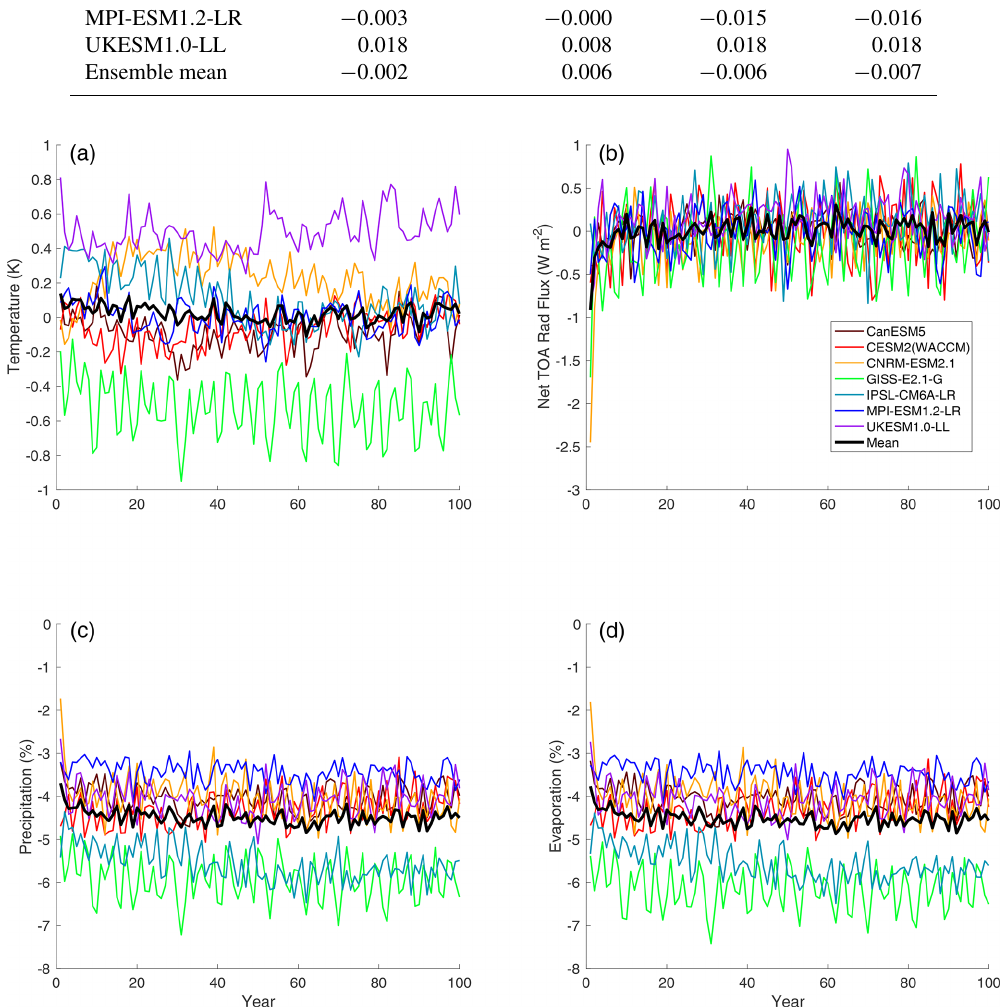
Figure 1. Temperature ( a ; K), net top-of-atmosphere radiative flux ( b ; Wm − 2 ), precipitation ( c ; %), and evaporation ( d ; %) change in G1 CMIP6 compared to piControl over 100 years of simulation. Thin colored lines are individual models, and thick black lines are ensemble